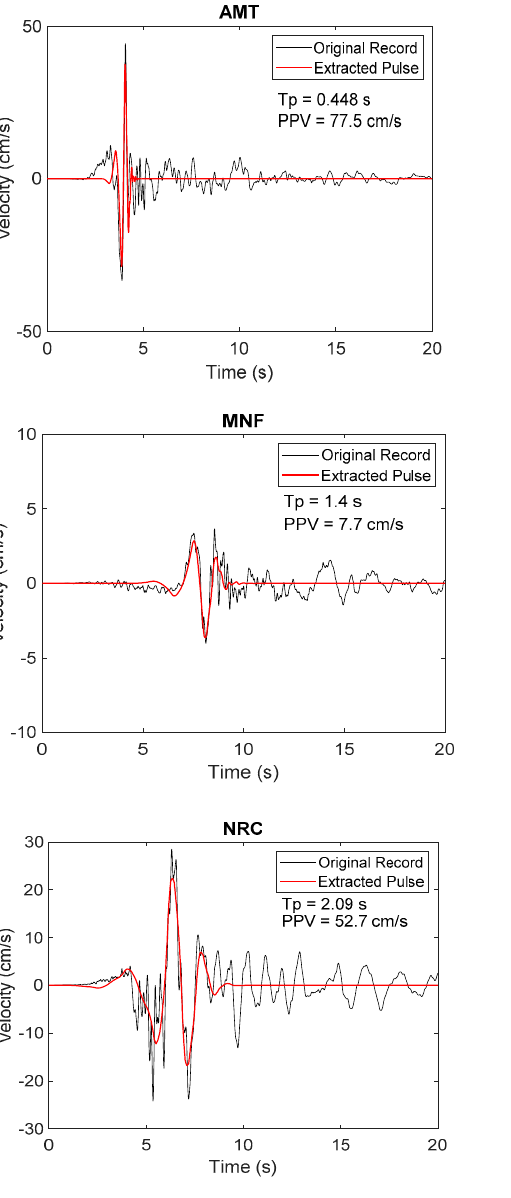
Figure 4. Velocity time series (black plots) and extracted pulses (red plots) of the fault normal (FN) components of the 6 seismic stations selected among those which recorded the strong ground motion on August 24, 2016.